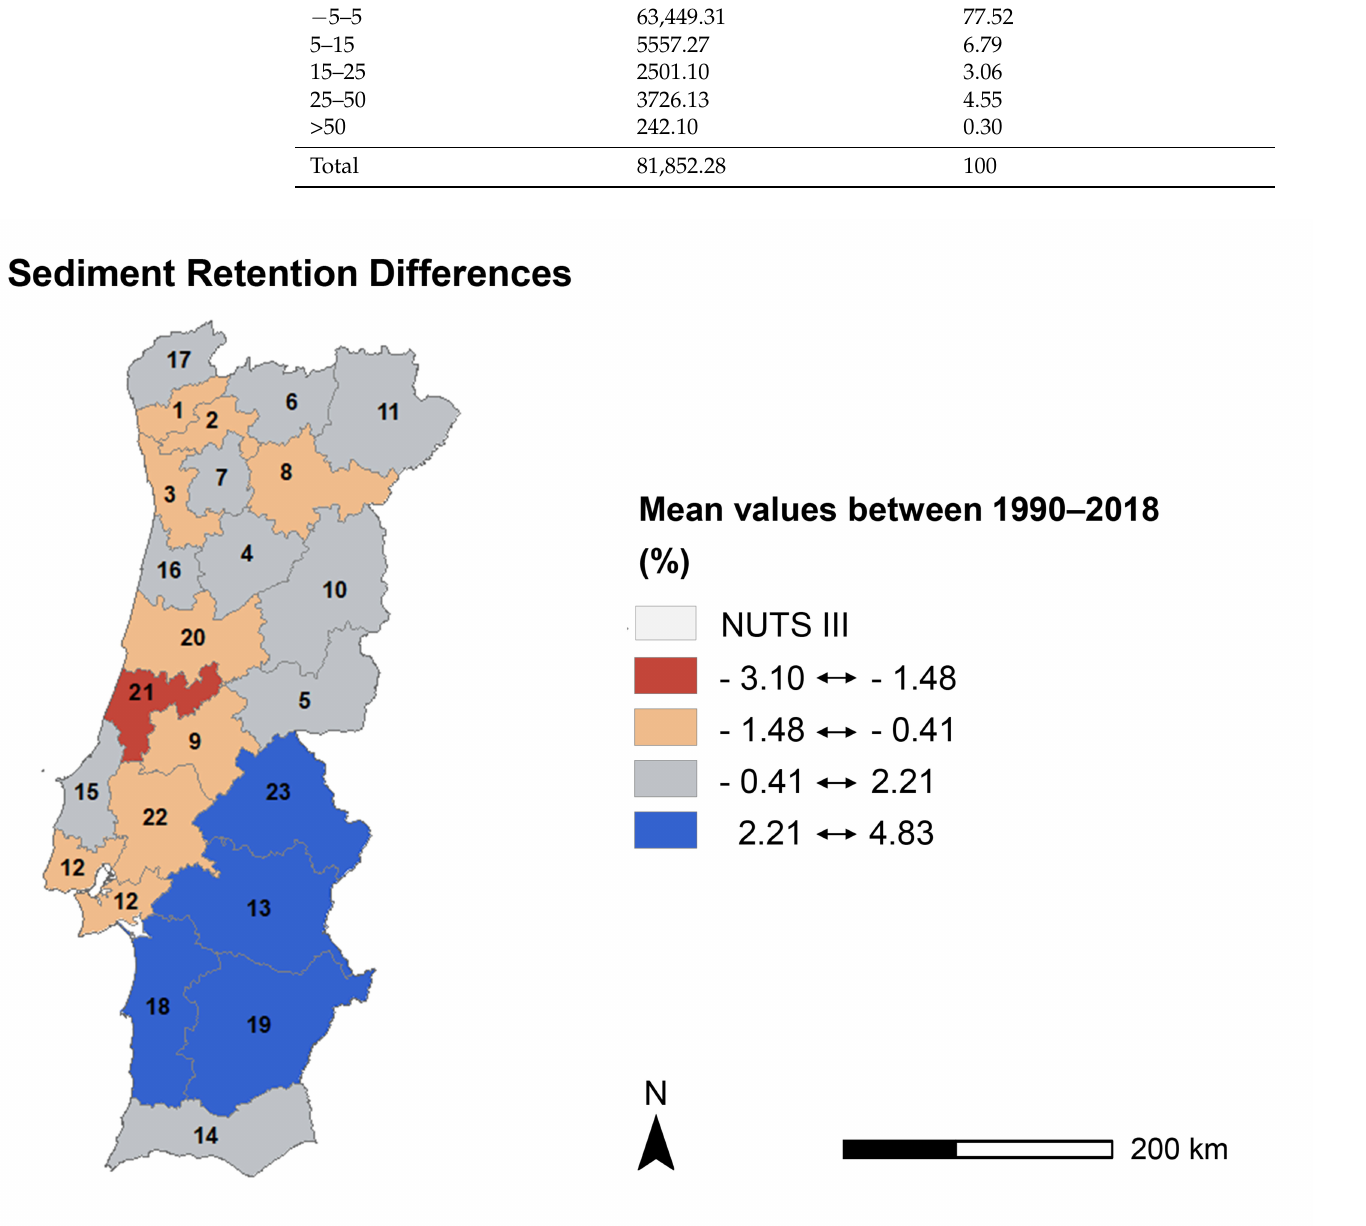
Figure 4. Zonal statistics analysis per NUTS III region for between 1990 and 2018 (mean values changes (%)) (classes obtained by natural breaks). 1. C á vado; 2. Ave; 3. Á rea Metropolitana do Porto; 4. Viseu D ã o Laf õ es; 5. Beira Baixa; 6.